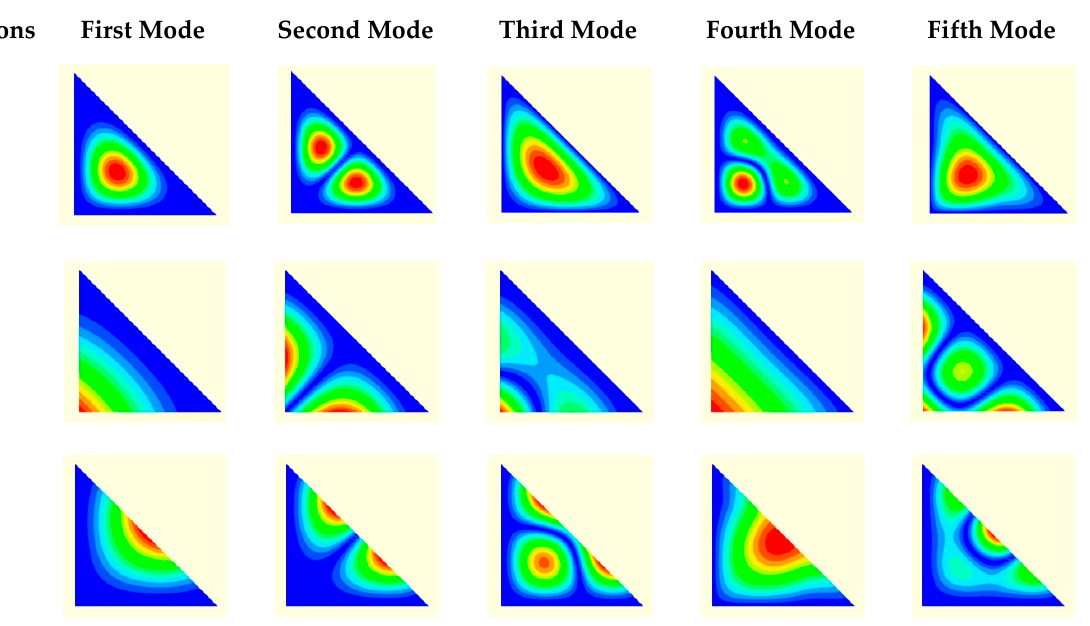
Figure 5. Contour plot of plate normal deflection for (C-C-C) plates; the flexural rigidity p / D t = 1.